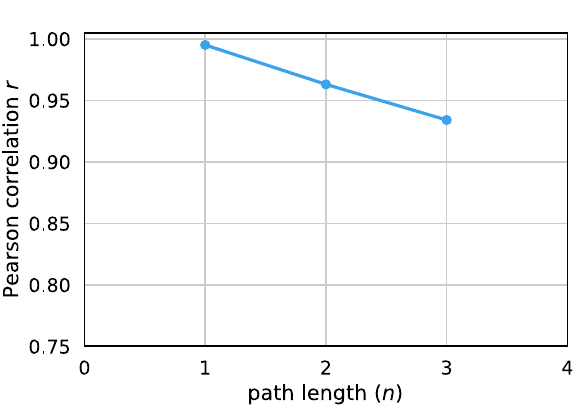
Fig. 7 Pearson ’ s r between the frequency of different structures in the collection of training trajectories and the collection of generated trajectories. Structures correspond to 1-paths (node labels), 2-paths, and 3-paths, as illustrated in Fig. 6.